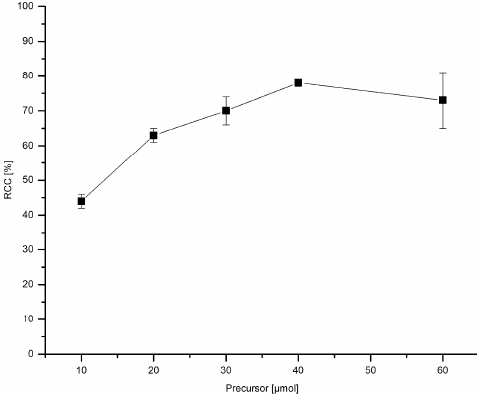
Figure 9. Dependency of RCC on precursor amount. Conditions: [ 18 F]Fluoride (~50 MBq) was eluted from a QMA-CO 3 cartridge with a solution of Et 4 NOTf (3.1 mg, 11 µmol) in n BuOH (300 µL) (see